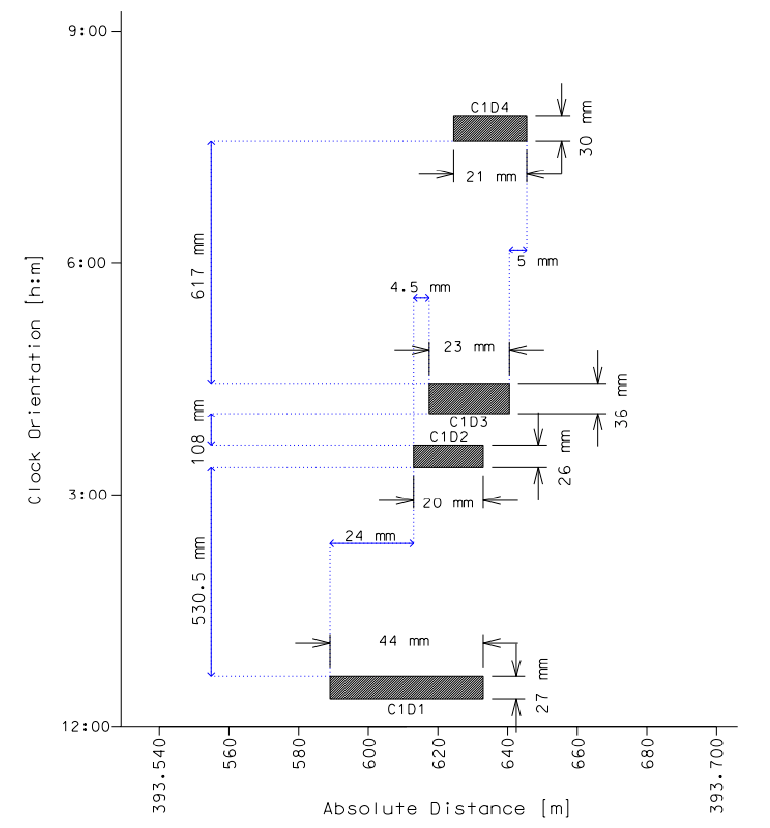
Figure 3. Graphical presentation of volumetric defects in colony 1. Source: Author’s analysis.